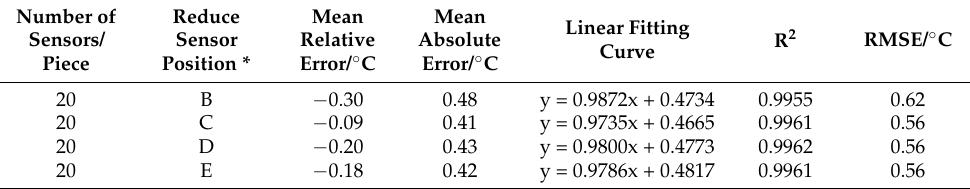
Table 4. Linear correlation analysis results after reducing 4 sensors.